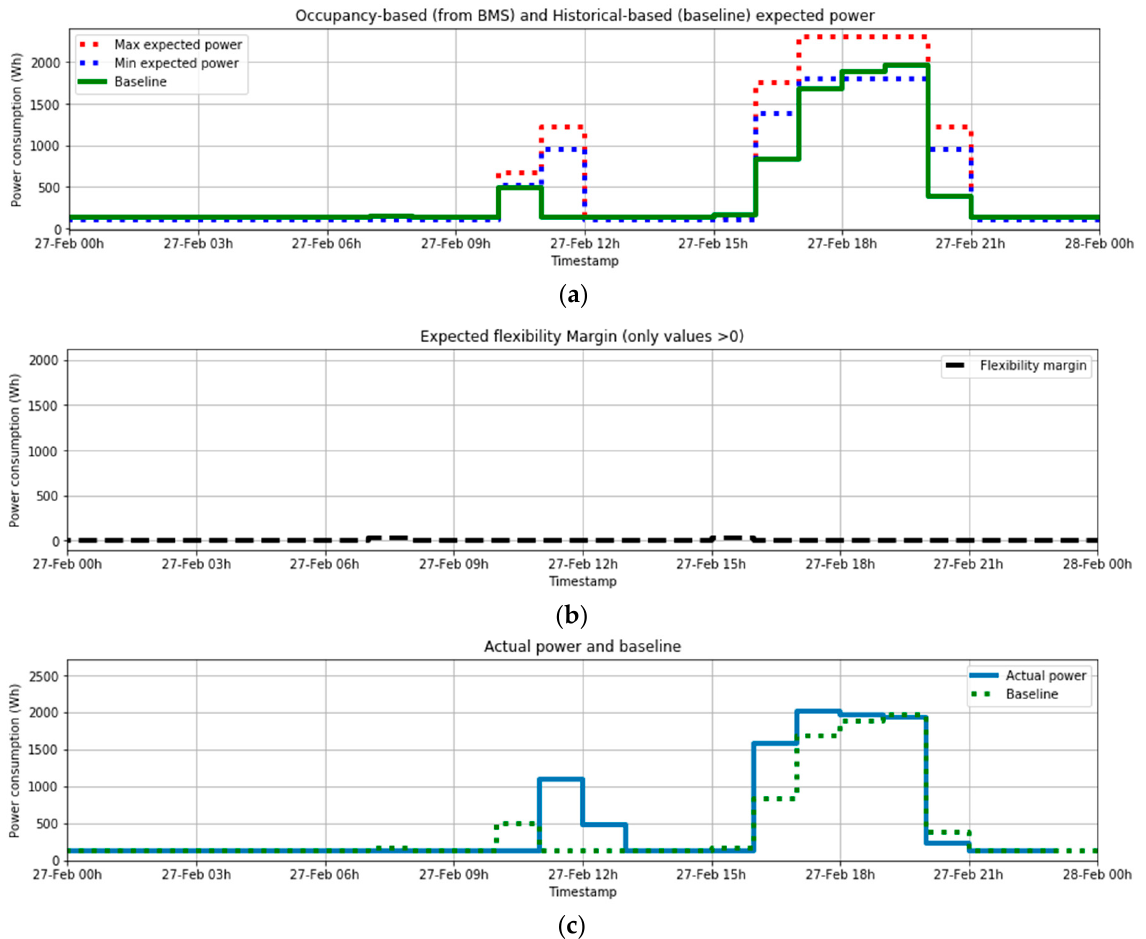
Figure 12. ( a ) Occupancy-based (from BMS) and Historical-based (baseline) expected power; ( b ) Expected flexibility Margin (only values >0); ( c ) Actual power and baseline.